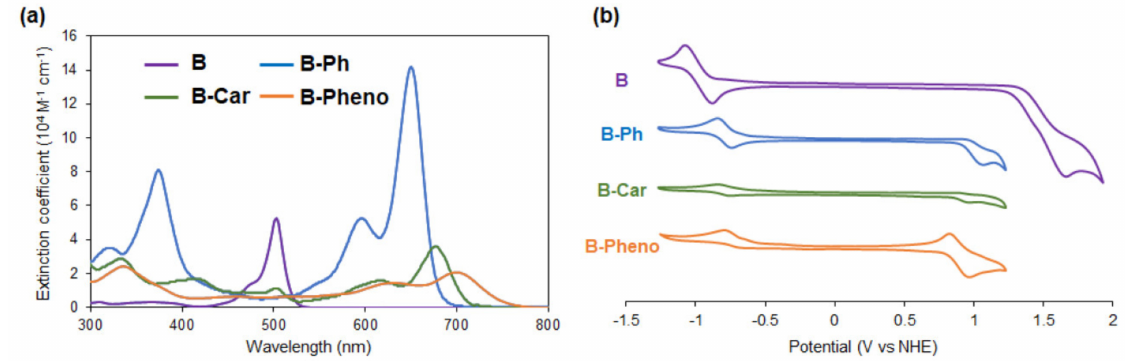
Figure 2. ( a ) Absorption and ( b ) CV spectra of B , B-Ph , B-Car , and B-Pheno in THF